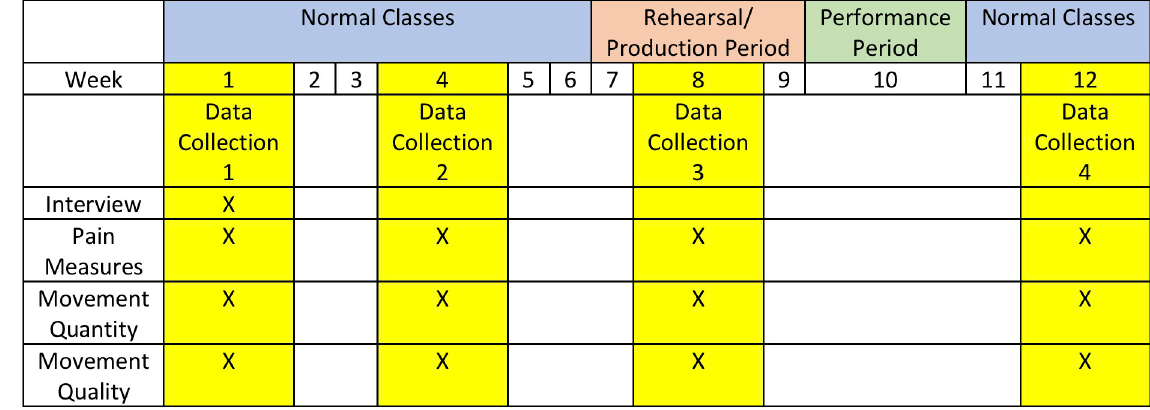
Fig 1. Data collection time periods across a university